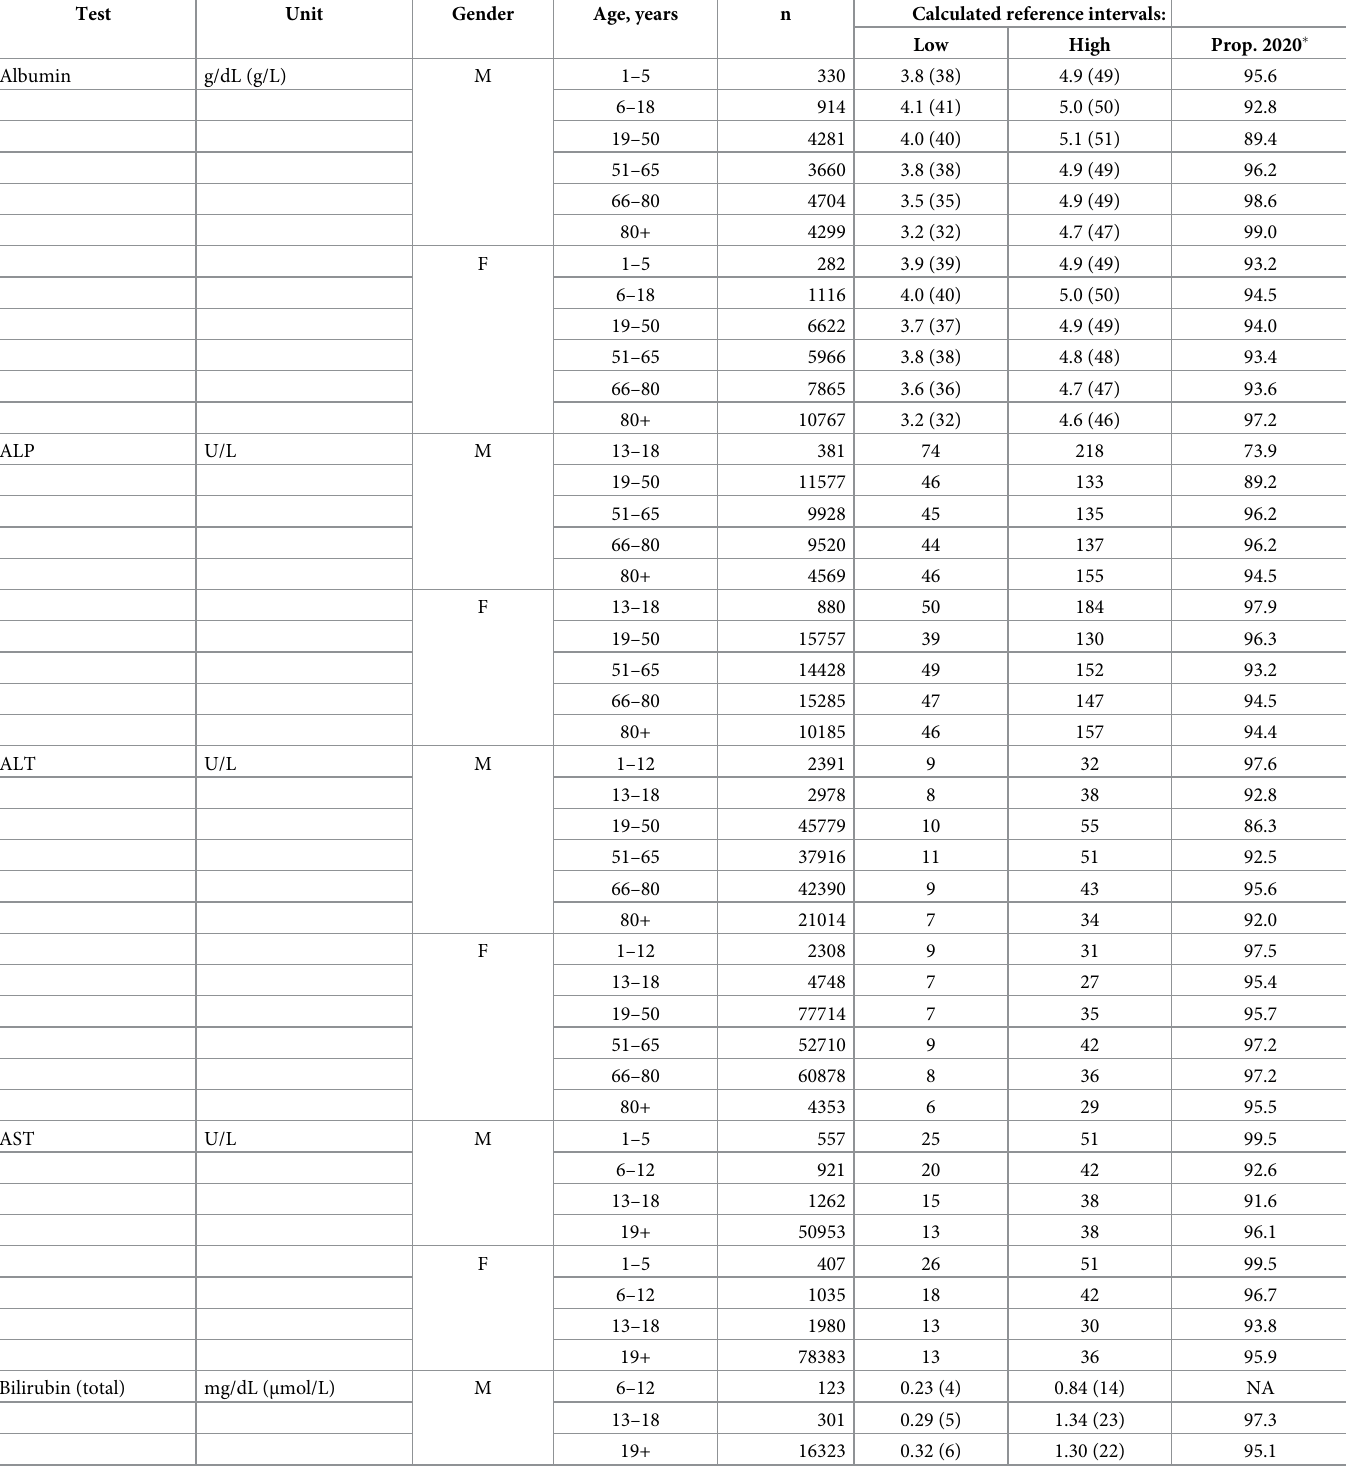
Table 1. Obtained Vall d’Hebron reference intervals results using the indirect approach from the NUMBER project, stratified for sex and age categories when necessary.